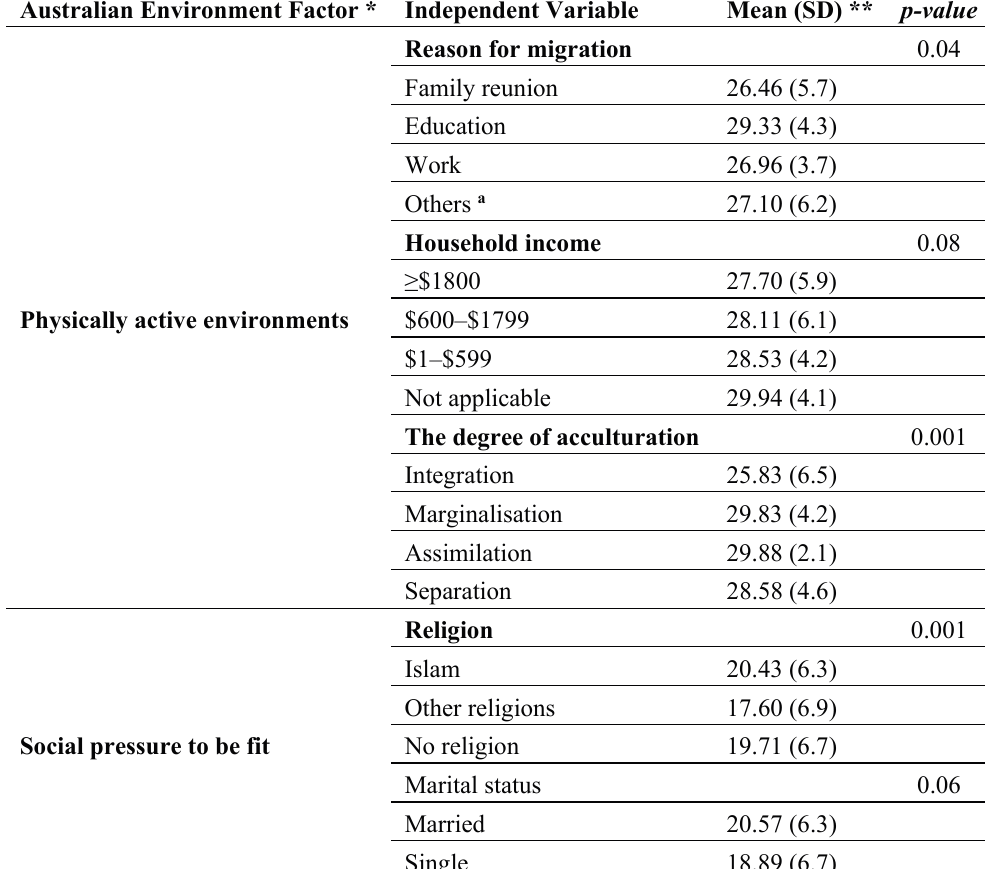
Table 2. ANOVA results—the association between environmental factors and independent